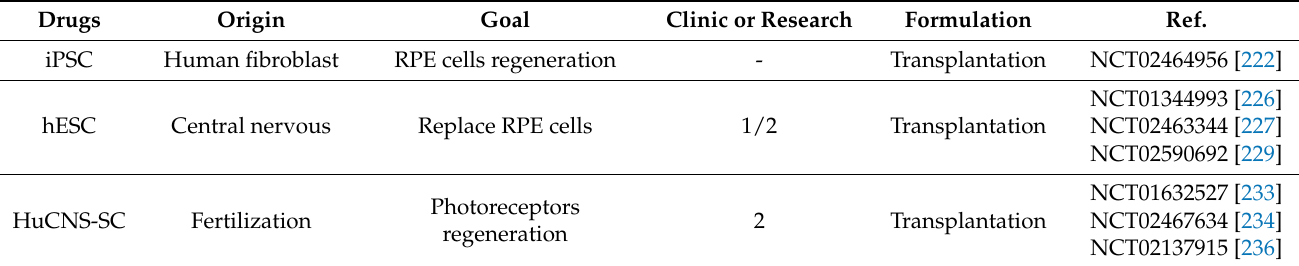
Table 8. Stem cells therapies against atrophic